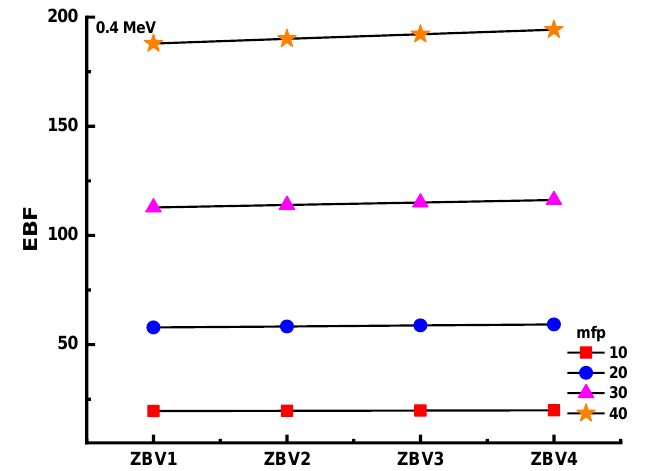
Figure 11. Variation of exposure buildup factor (EBF) against glass compositions.